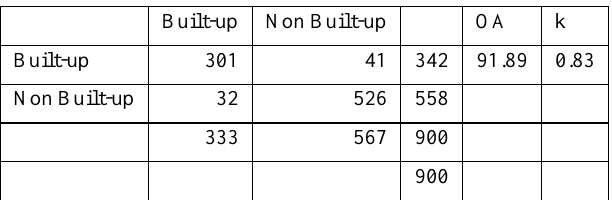
Table 3. Accuracy assessment